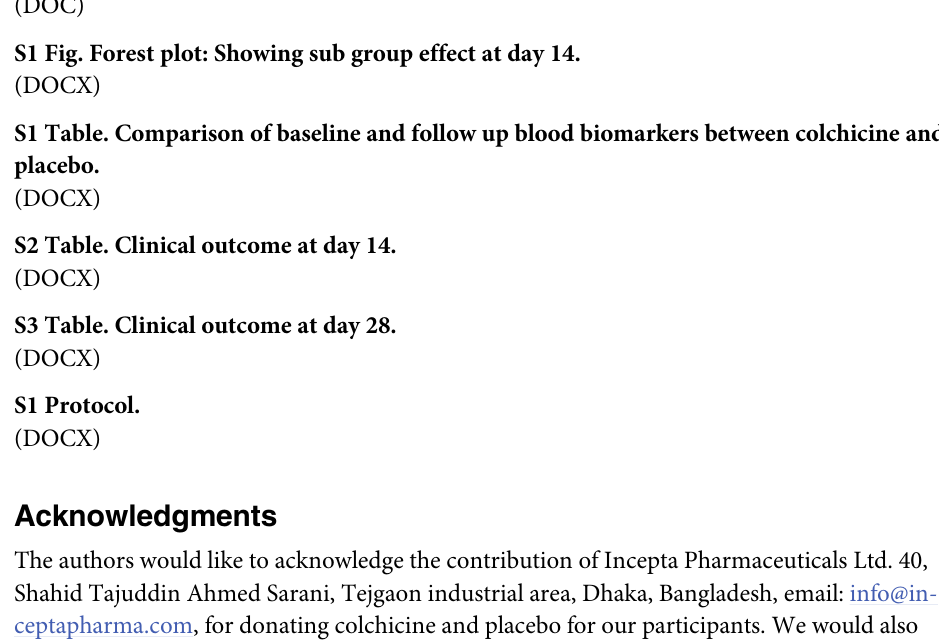
S1 Fig. Forest plot: Showing sub group effect at day 14. S1 Table. Comparison of baseline and follow up blood biomarkers between colchicine and placebo. S2 Table. Clinical outcome at day 14. S3 Table. Clinical outcome at day